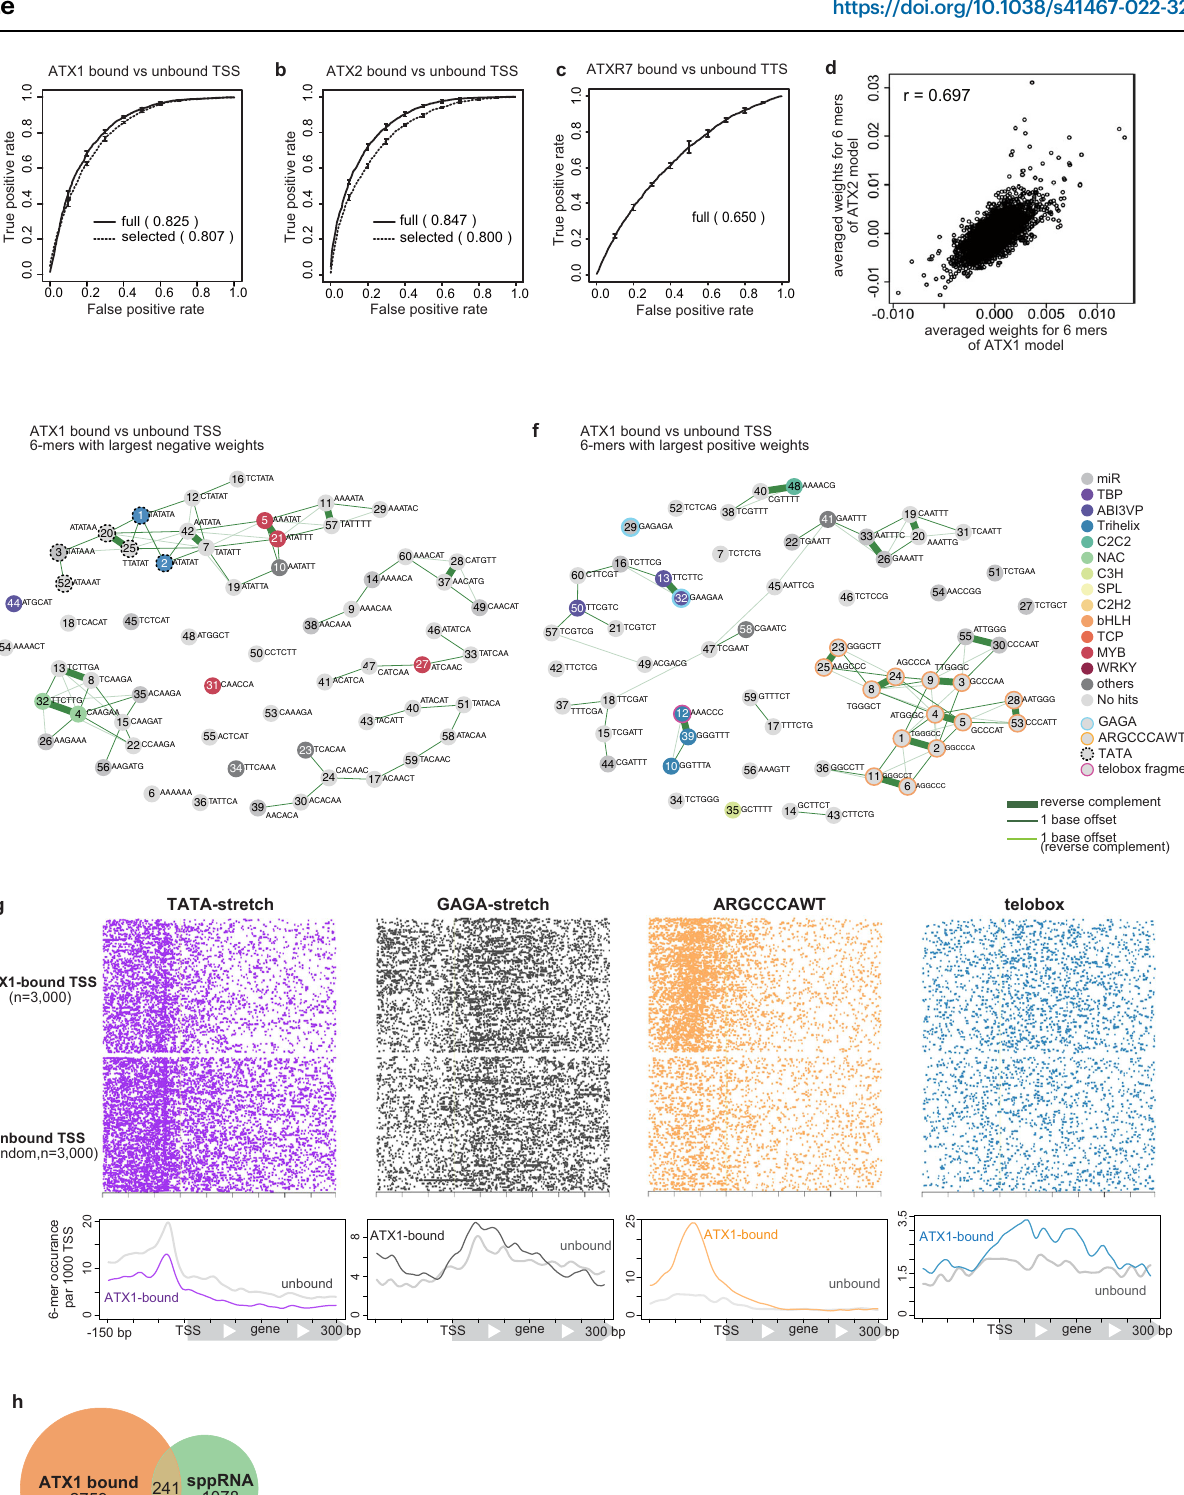
6-mers with largest negative weights